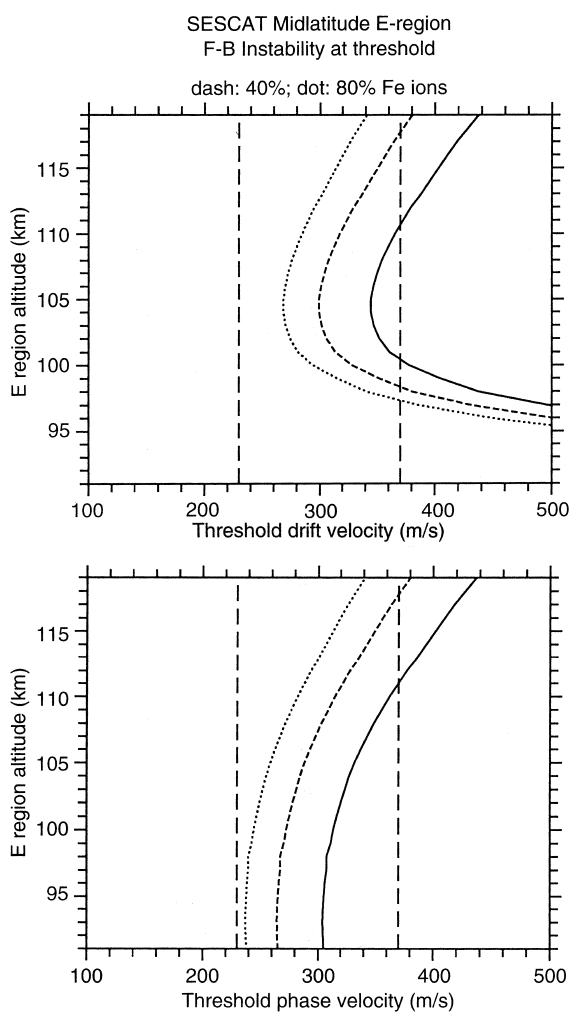
Fig. 8 . Linear fluid-theory predictions of the electron-to-ion drift velocity at the two-stream instability threshold ( upper panel ) and the corresponding phase velocity of type-1 waves. The solid curves are for molecular ions; the dashed and dotted curves are for higher mean ionic masses due to the presence of heavy Fe + ions inside sporadic- E -layers. See text for details